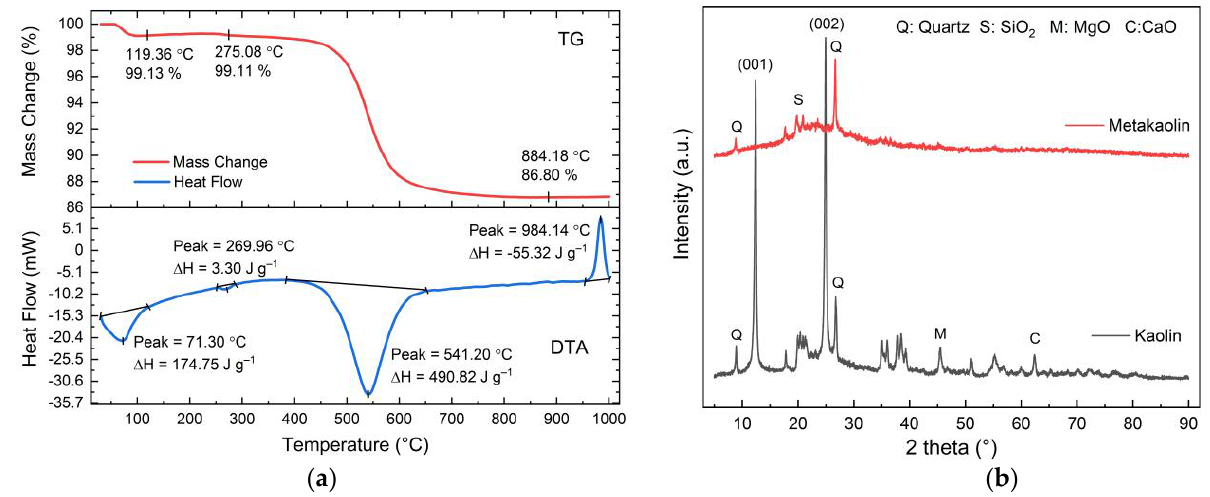
Figure 2. ( a ) TG/DTA of kaolin measured in the range of 25–1000 °C with a heating rate of 10 °C/min. The endotherm peak at 541 °C indicates the phase change of kaolin from crystalline state into an amorphous state, and ( b ) diffractogram of kaolin and metakaolin. Dehydroxylation at 750 °C changes the crystallinity of kaolin into an amorphous metakaolin.